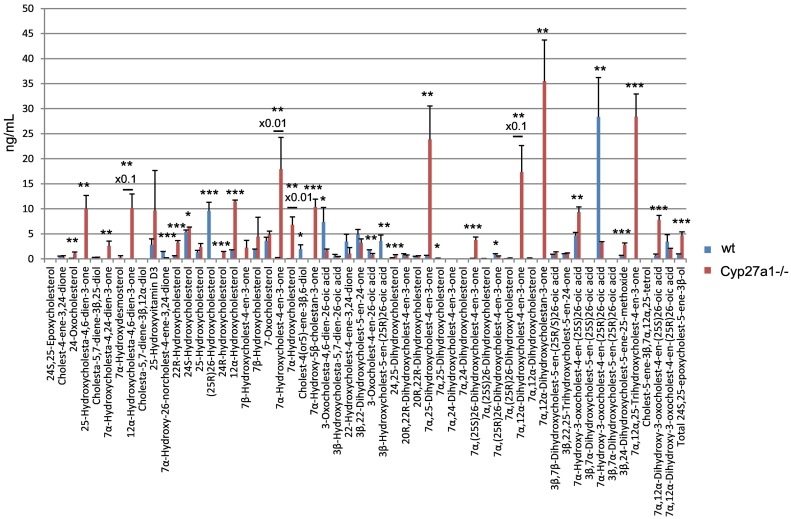
Concentrations of oxysterols and cholestenoic acids in Cyp27a1−/− (n = 3) and Cyp27a1+/+ (wt, n = 3) mouse plasma. No hydrolysis or solvolysis steps were performed so the values reported are for “free” non-esterified molecules. Sterols are arranged according to mass and chromatographic order of elution of the GP-derivative. To maintain a single y-axis magnification factors have been applied as indicated. Using the EADSA method 24S,25-epoxycholesterol isomerises to 24-oxocholesterol, becomes hydrolysed to 24,25-dihydroxycholesterol and undergoes methanolysis to 3β,24-dihydroxycholest-5-ene-25-methoxide. The total 24S,25-epoxycholesterol corresponds to the sum of the individual forms.